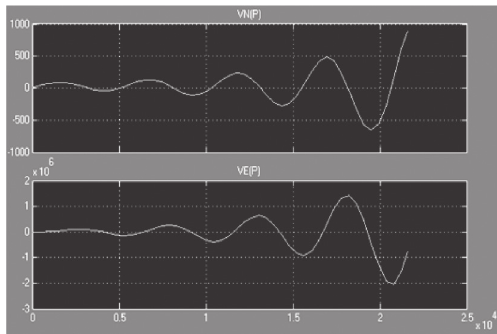
Fig. 10. Graphs of error rates of the two channels of an inertial system when between the channels there are cross- connections with coefficients of transmission knpv = 0.001,